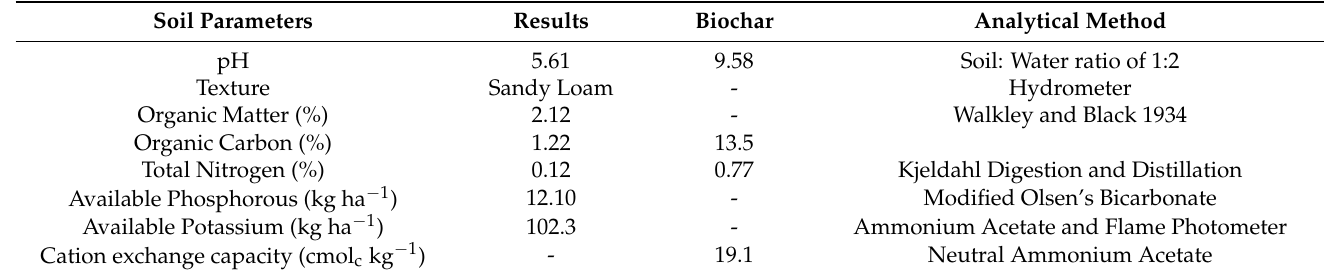
Table 3. Initial Soil